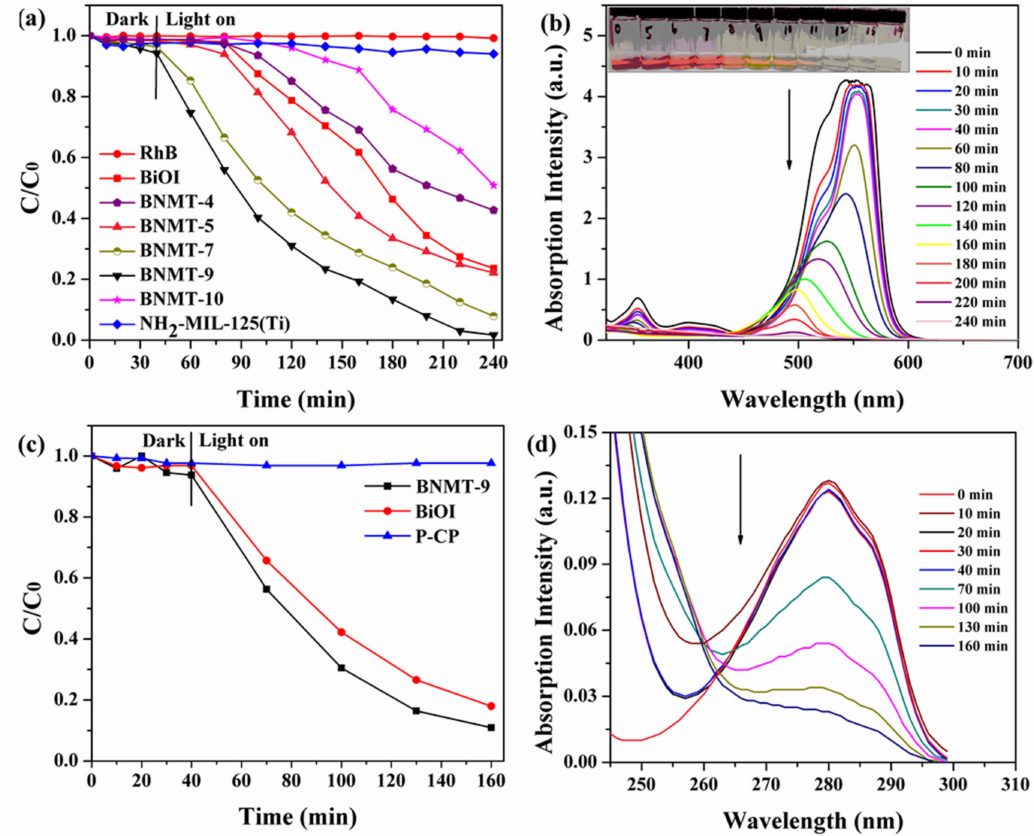
Figure 8. Photocatalytic degradation efficiencies of ( a ) RhB with initial concentration of 40 mg/L and ( c ) P-CP with an initial concentration of 10 mg/L over different catalysts under visible-light irradiation, and time-dependent UV–vis absorption total spectra of BNMT-9 degradation ( b ) RhB and ( d )